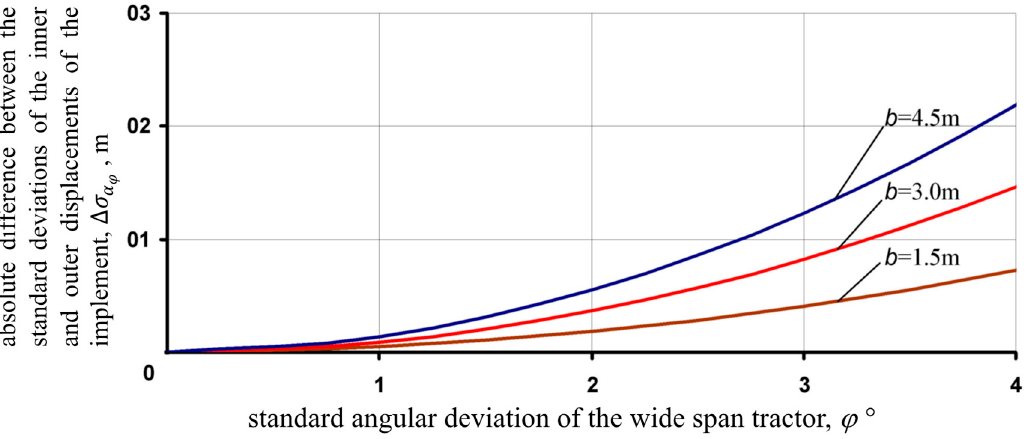
Figure 4. The absolute difference between the inner and outer standard deviations of displacements of the working implement depending on the standard deviations of the angular deflections of the wide span tractor, considering different values of b